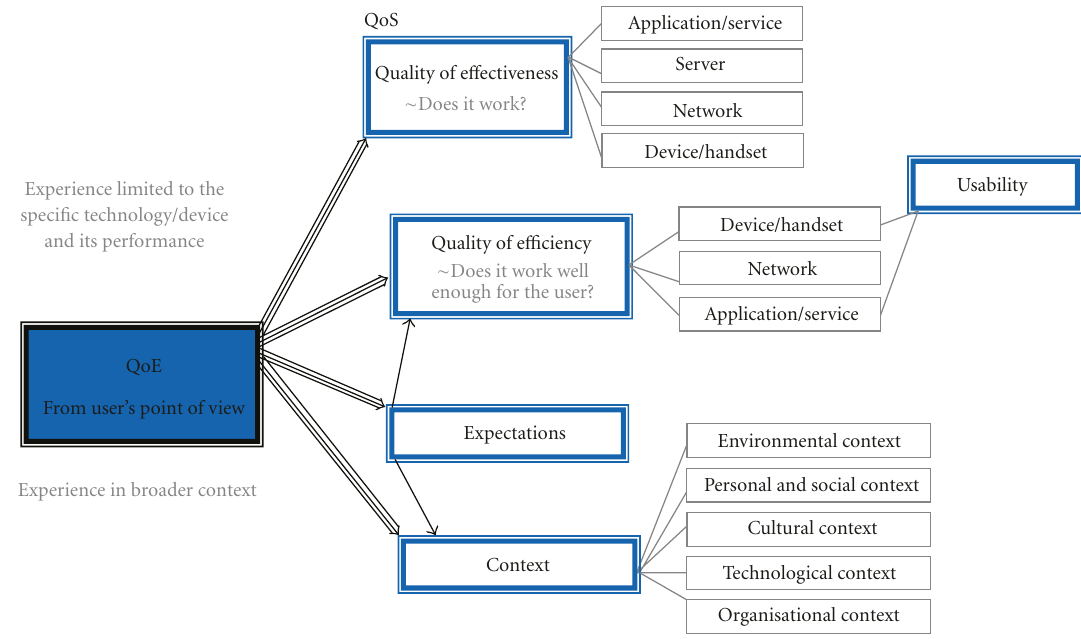
Figure 1: Conceptual model of QoE